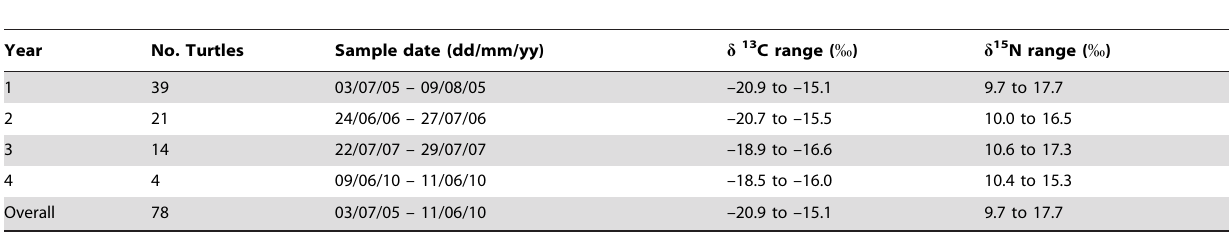
Table 1. Summary of leatherback tissue sampling and d 13 C and d 15 N values for turtles nesting in Jamursba Medi, Papua Barat, Indonesia.